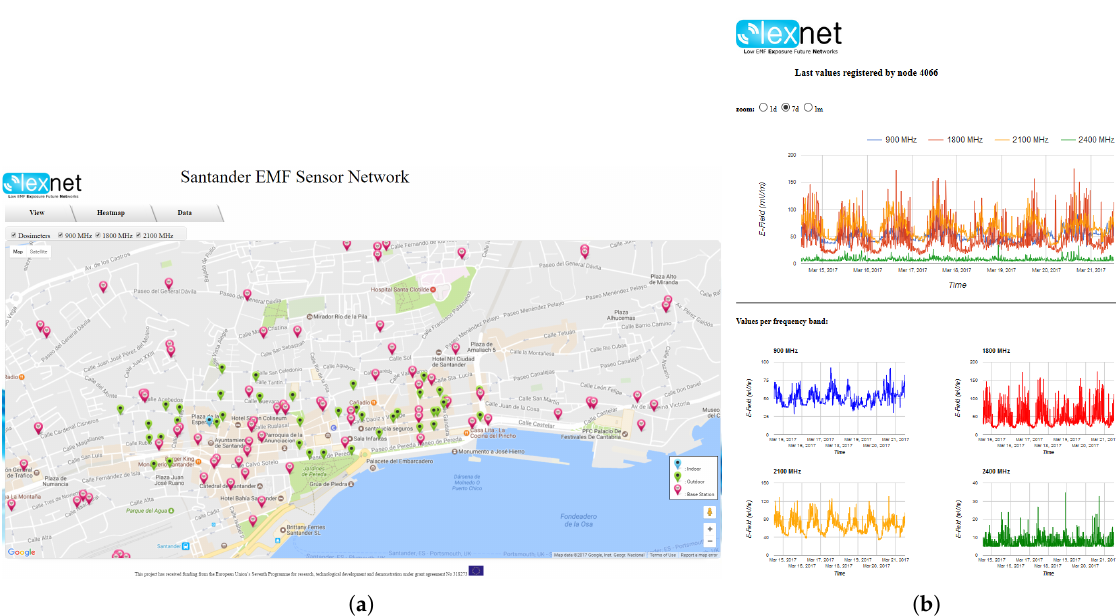
Figure 6. Web portal: deployment map and E-Field variation at a single dosimeter. ( a ) LEXNET deployment; ( b ) E-field variation.